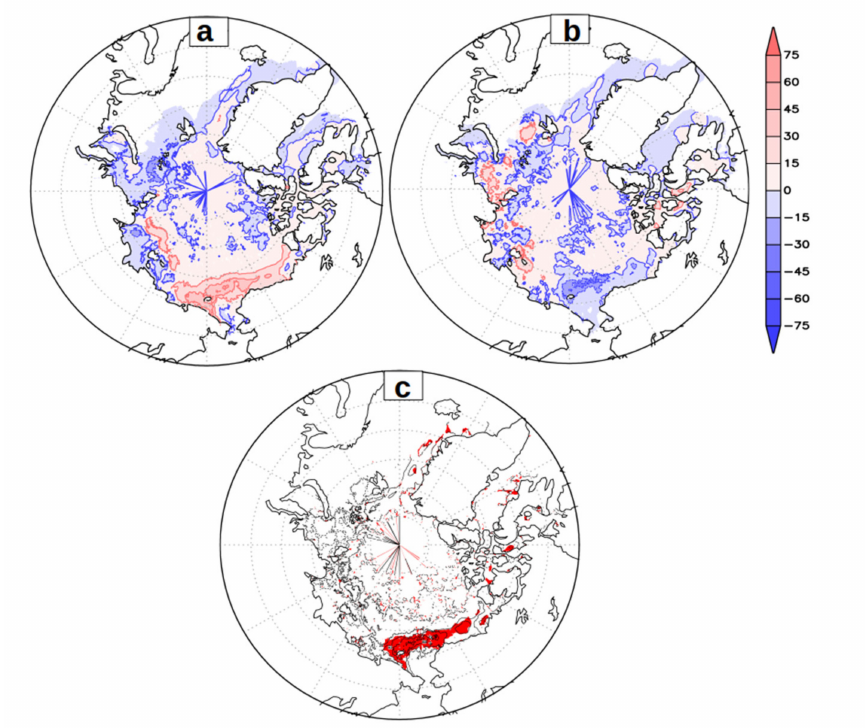
Figure 4. Composites sea ice concentration anomalies for ( a ) strong ISM years ( b ) weak ISM years, and ( c ) the difference between ( a , b ) with statistically significant regions shaded at a 95% significance